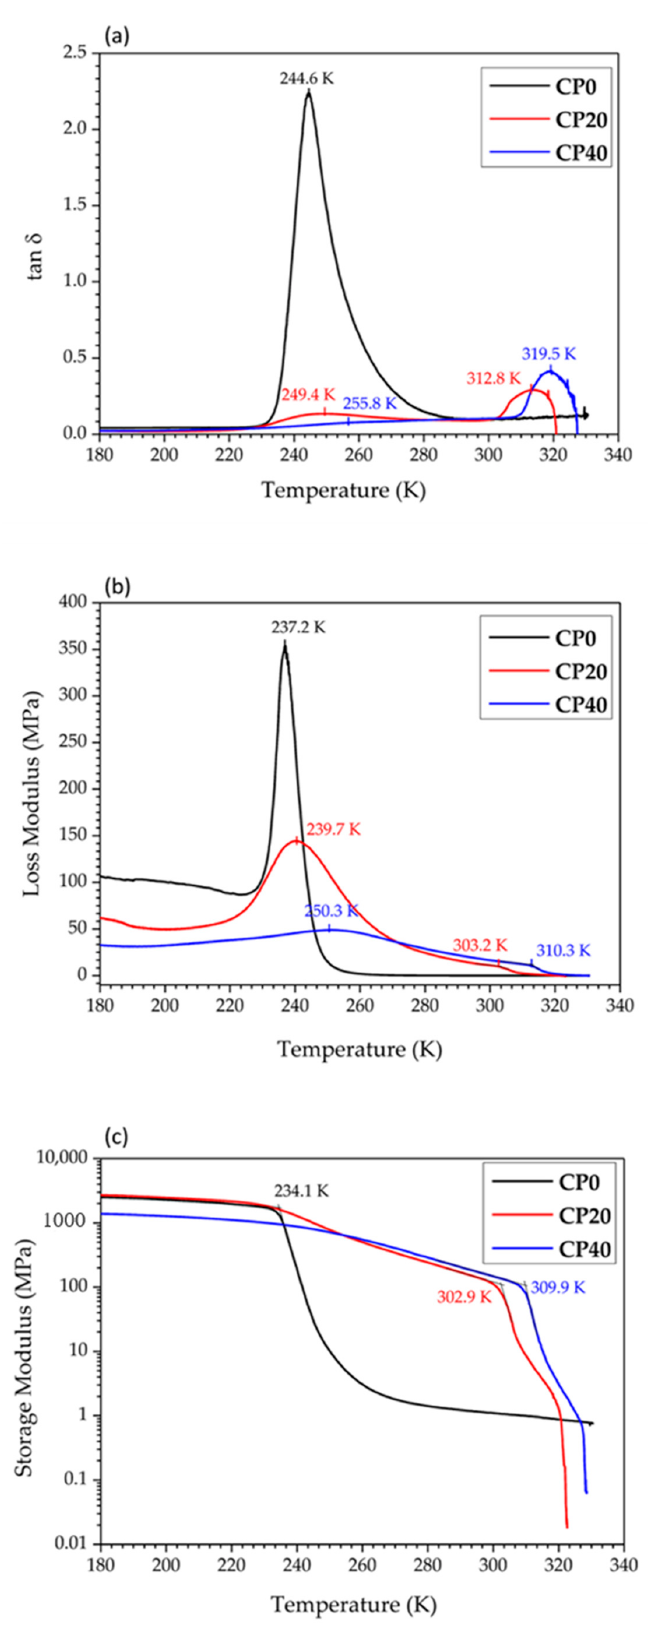
Figure 5. DMTA analysis for CP0, CP20 and CP40 samples. ( a ) Tan δ , ( b ) loss modulus and ( c ) storage modulus evolution with temperature.